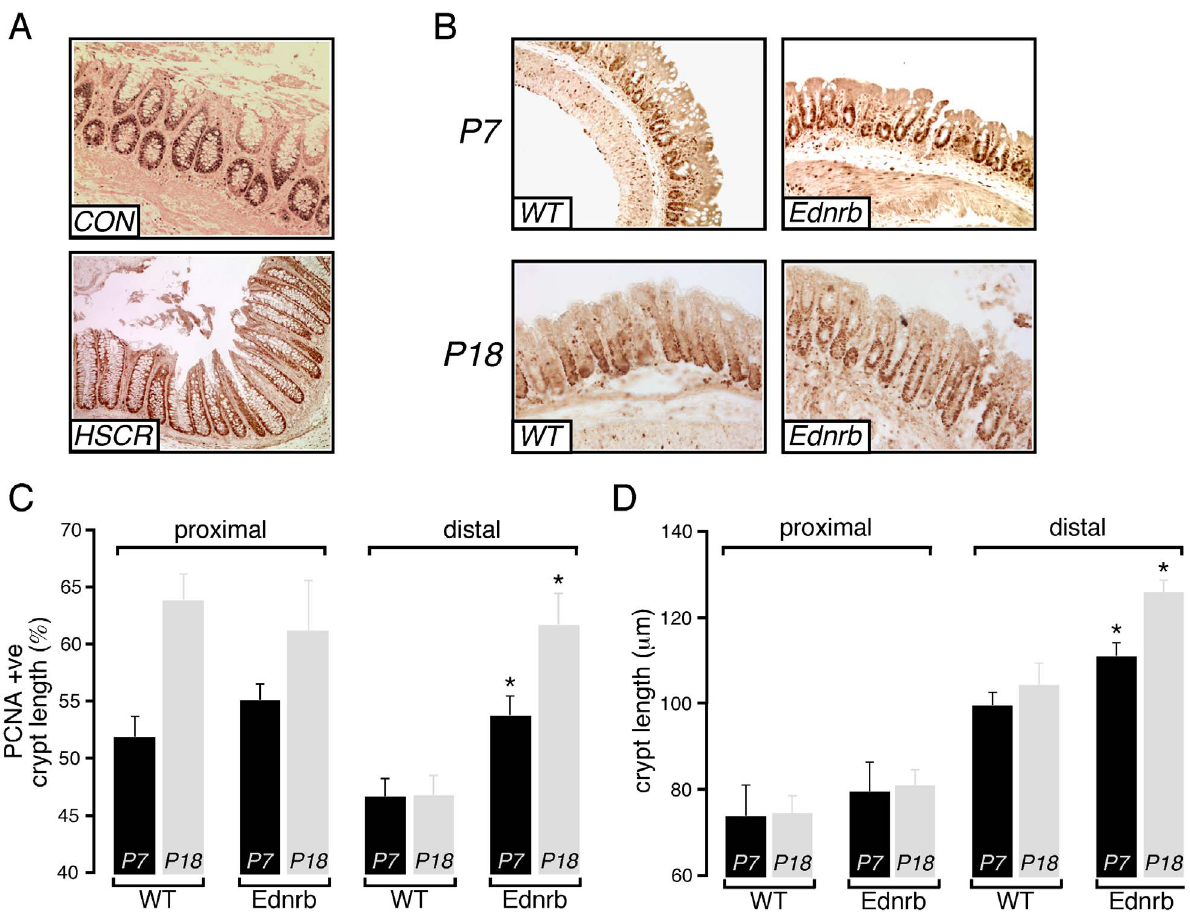
Figure 1. Colon crypt proliferation in Ednrb 2 / 2 mice. A. Representative images showing PCNA staining of crypt cells from human distal colon from control (CON) and HSCR patients. B. Representative images showing PCNA staining of crypt cells from distal colon of P7 and P18 WT and Ednrb 2 / 2 mice. C. Summary graph showing extent of PCNA-immunoreactive zone (% of total crypt length that is PCNA-positive) in the epithelium of proximal and distal colon from WT (n=5) and Ednrb 2 / 2 mice (n=5). D. Mean crypt length in proximal and distal colon from WT (n=5) and Ednrb 2 / 2 mice (n=5). *p , 0.05.